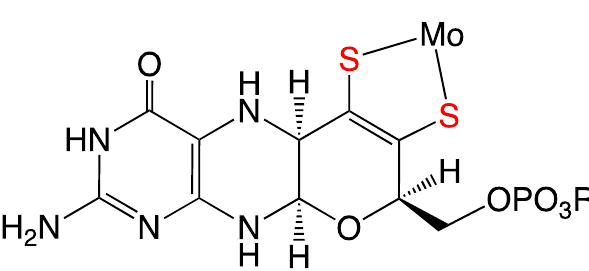
Figure 1. The reduced tetrahydro form of the pyranopterin dithiolene (PDT) coordinated to Mo in the molybdenum cofactor (Moco). In the enzymes, the Mo ion can redox cycle between the Mo IV , Mo V , and Mo VI oxidation states.